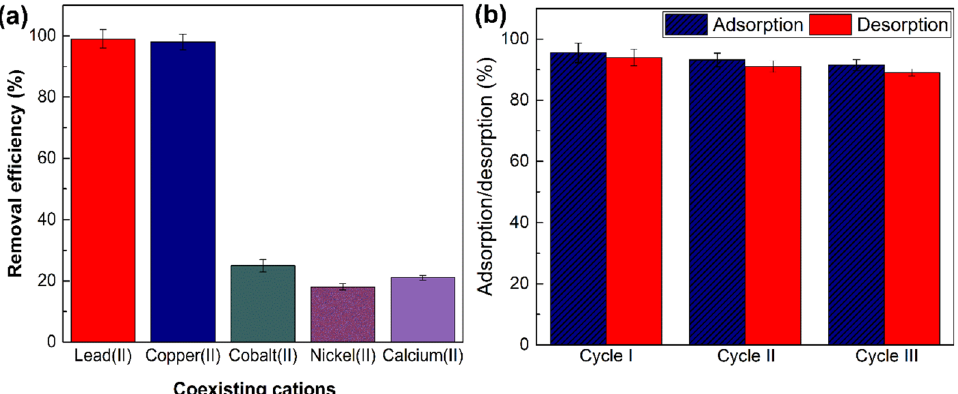
Figure 6. Effect of coexisting ions on lead(II) removal ( a ). pH 6, adsorbent dose: 60 mg/L, initial cation concentration: 50 mg/L, contact time: 90 min, T: 298 K. Reusability of the PmPDA@ZnO, adsorption/ desorption percentages of lead(II) during three cycles ( b